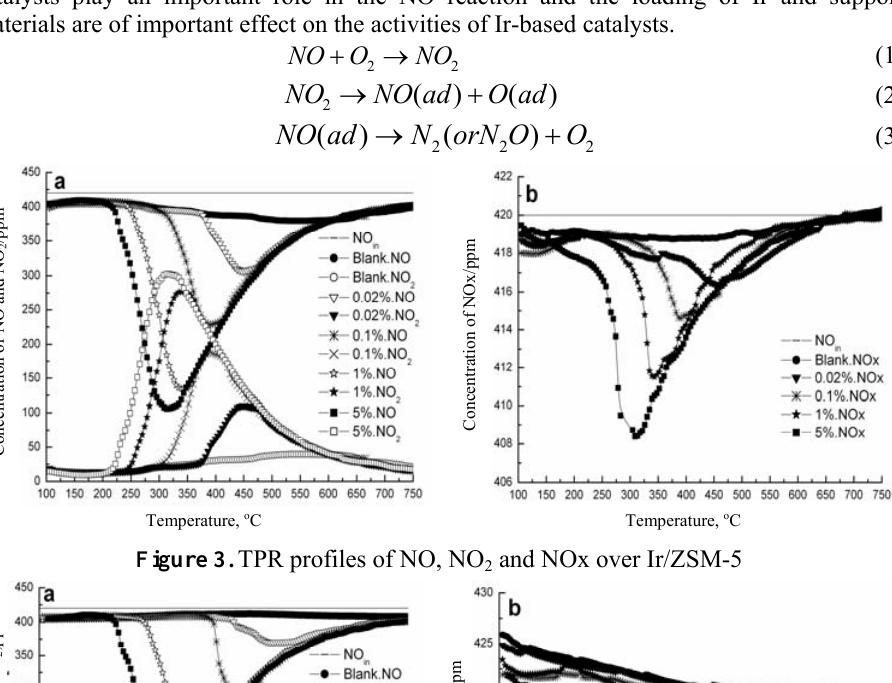
Figure 3. TPR profiles of NO, NO